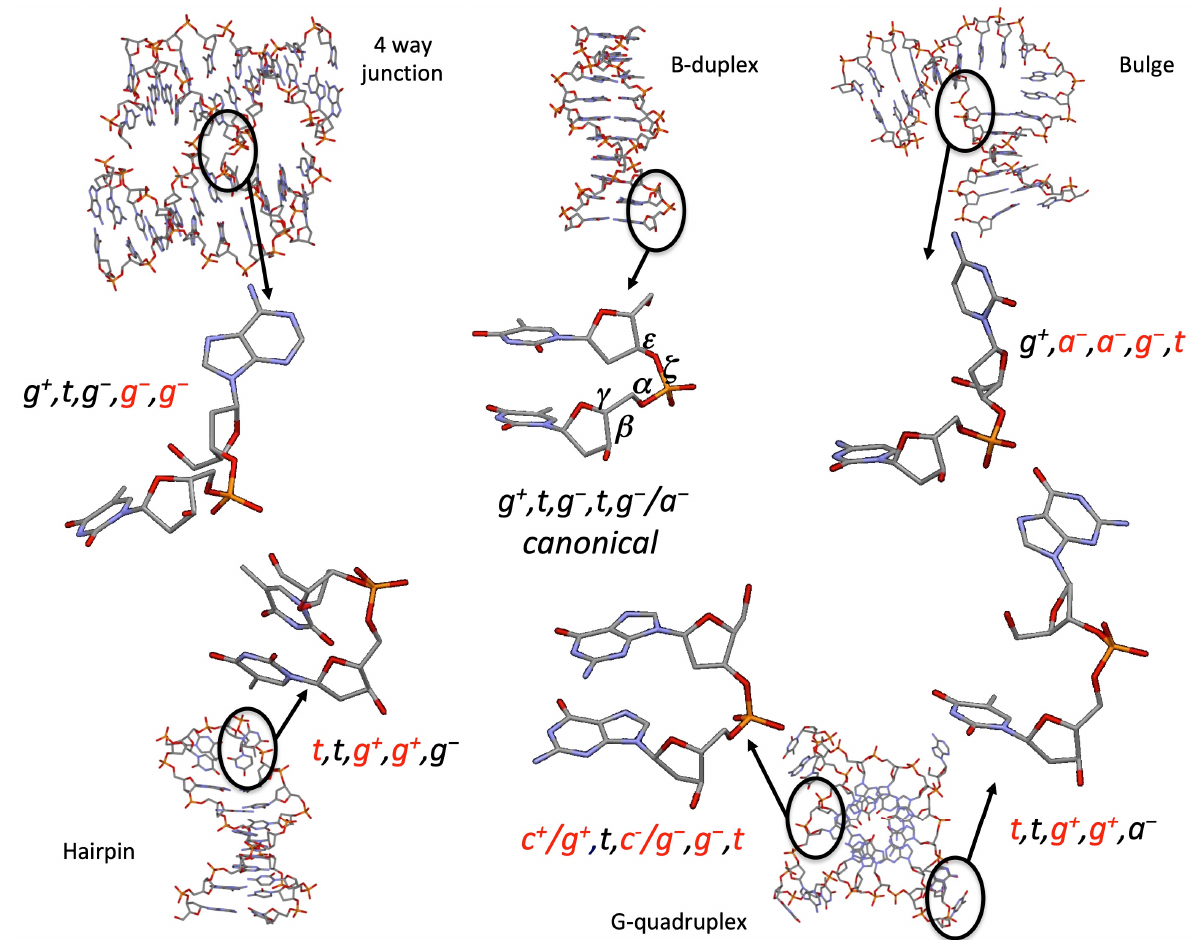
Figure 2. Examples of DNA secondary structures and associated backbone torsion angles γ / β / α / ε / ζ of representative dinucleotide units. The following 6-fold staggered pattern of the torsional angles is used: cis = 0 ± 30° (c), gauche(+) = 60 ± 30° (g + ), anticlinal(+) = 120 ± 30° (a + ), trans = 180 ± 30° (t), anticlinal( − ) = 240 ± 30° (a − ), gauche( − ) = 300 ± 30° (g − ). The notation g − / a − is used to designate a torsion angle on the border of gauche( − ) and anticlinal( − ). PDB ID: Hairpin, 1ii1; duplex, 436d; Bulge, 1jrv; 4-way junction, 1zez; G-quad, 1kf1.